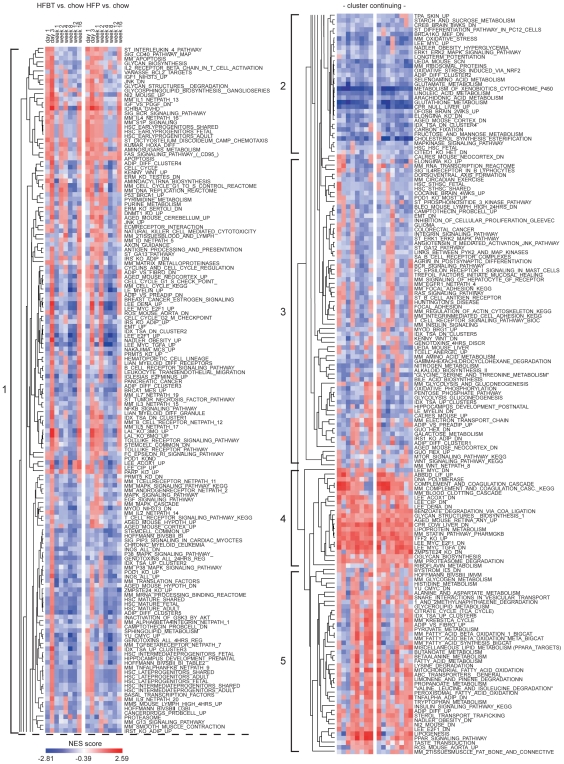
Temporal modules of pathway activities during the hepatic high-fat response.Hierarchical clustering (Pearson correlation (uncentered), average linkage) of Normalized Enrichment Scores (NES), as determined by Gene Set Enrichment Analysis. The NES values of 314 gene sets, significant (FDR q-value<0.1) in at least one of HFBT vs. chow and HFP vs. chow per time-point comparisons are used as an input for hierarchical clustering. The NES scores, represented by the color gradient, correspond to the relative up- (red) and down- (blue) regulation of the gene sets under each of experimental conditions. The cluster diagram can be divided into five main temporal themes (depicted as modules 1 to 5), highlighting the main trends in temporal pathway activities: (1) early activation/late repression; (2) constant repression; (4) constant activation and (5) early repression/mid and late activation. Module (3) includes fuzzy pathway profiles that bring to light differences in transcription response to beef tallow- (HFBT) and palm oil-based (HFP) high-fat diets.